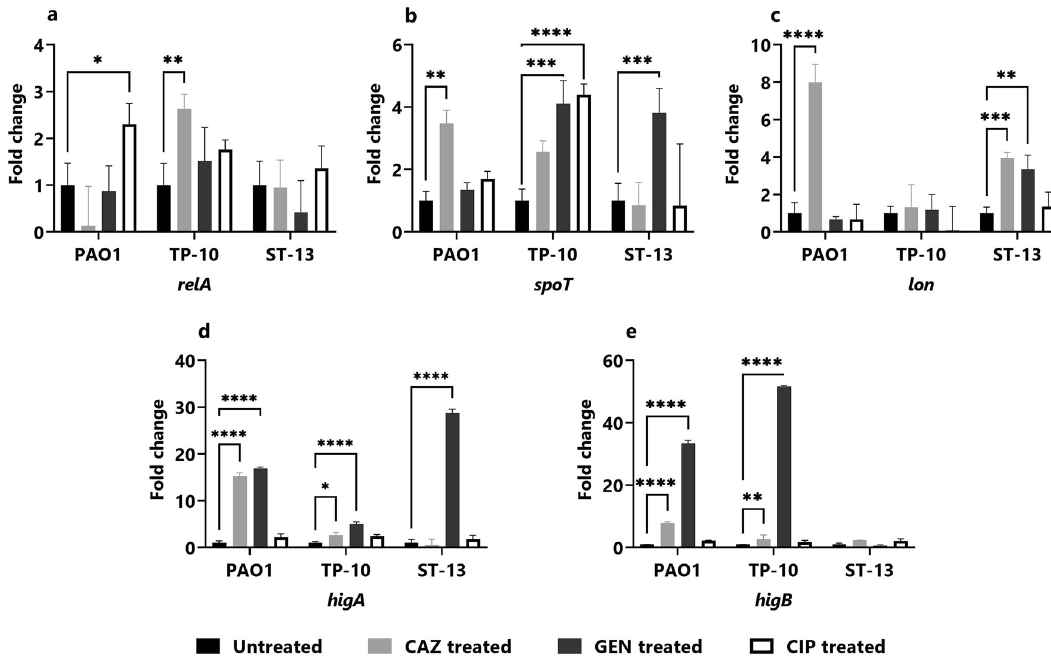
Figure 4. Gene expression studies in the planktonic stage. The gene expression of stringent response genes: ( a ) relA , ( b ) spoT , and ( c ) lon as well as toxin–antitoxin genes; ( d ) higA and ( e ) higB was studied in PAO1, TP-10 and ST-13 isolate after 4 h of antibiotic (CAZ, GEN, and CIP) treatment. The gene expression was normalized with untreated control. CAZ: ceftazidime, GEN: gentamicin, and CIP: ciprofloxacin. The experiment was performed in three biological experiments for each strain. Data represent the mean ± standard deviation of fold change. The Statistical analysis was performed using the two-way ANOVA, which was * P < 0.05, ** P < 0.01, *** P < 0.001, and **** P <